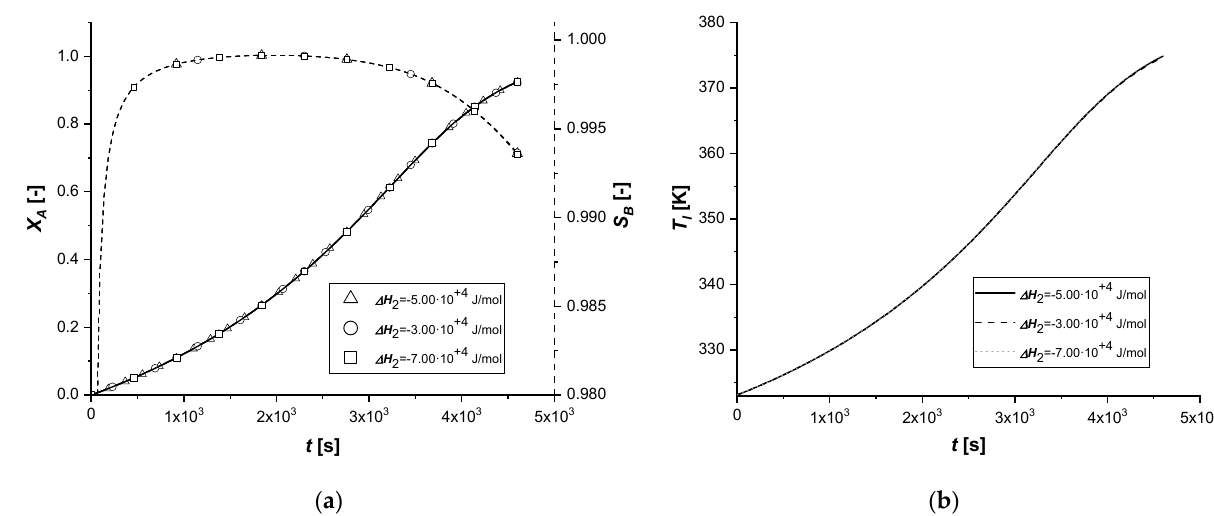
Figure 8. ES Δ rH 2 investigation. ( a ) Bulk profiles over time of X A and S B . ( b ) Bulk profile of T l over time.